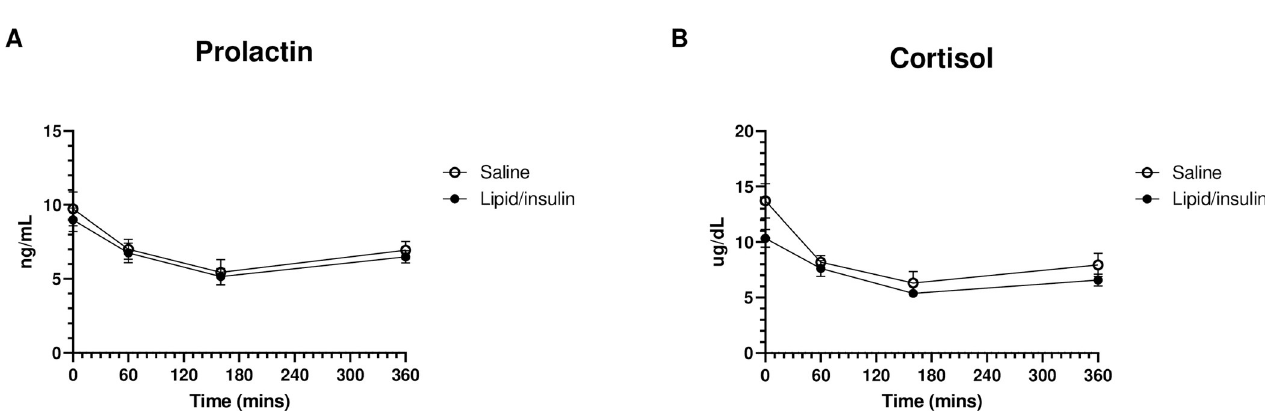
Fig 5. Prolactin and cortisol are unaffected by lipid/insulin infusions. Pooled levels of (A) serum prolactin and (B) cortisol (n = 12) were measured at approximately 0, 60, 160, and 360-minutes, as described in methods; values are mean ± SEM.